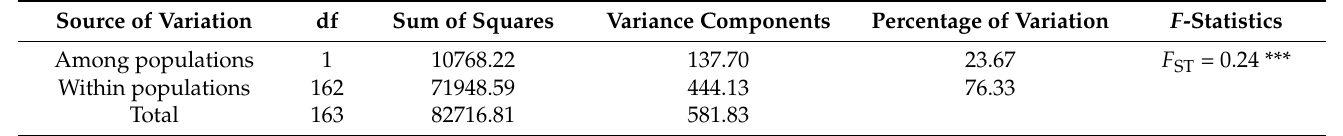
Table 2. Analysis of molecular variance (AMOVA) of 82 R. apiculata accessions in Thailand.